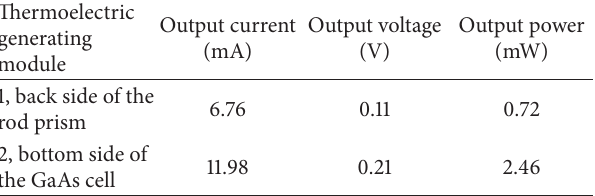
Figure 7: The output power comparason of mechnismsproposed in this reaserch. Table 4: The output energy of the correspondent thermoelectric generating module 1 and